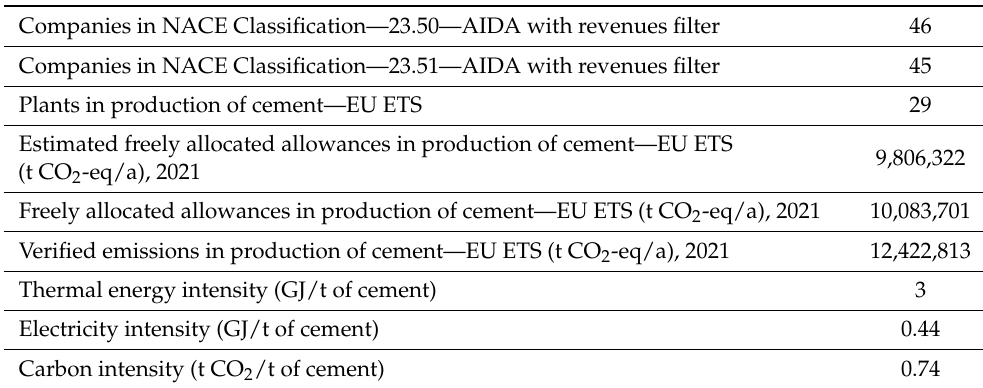
Table 7. Summary data for cement production plants in Italy under EU